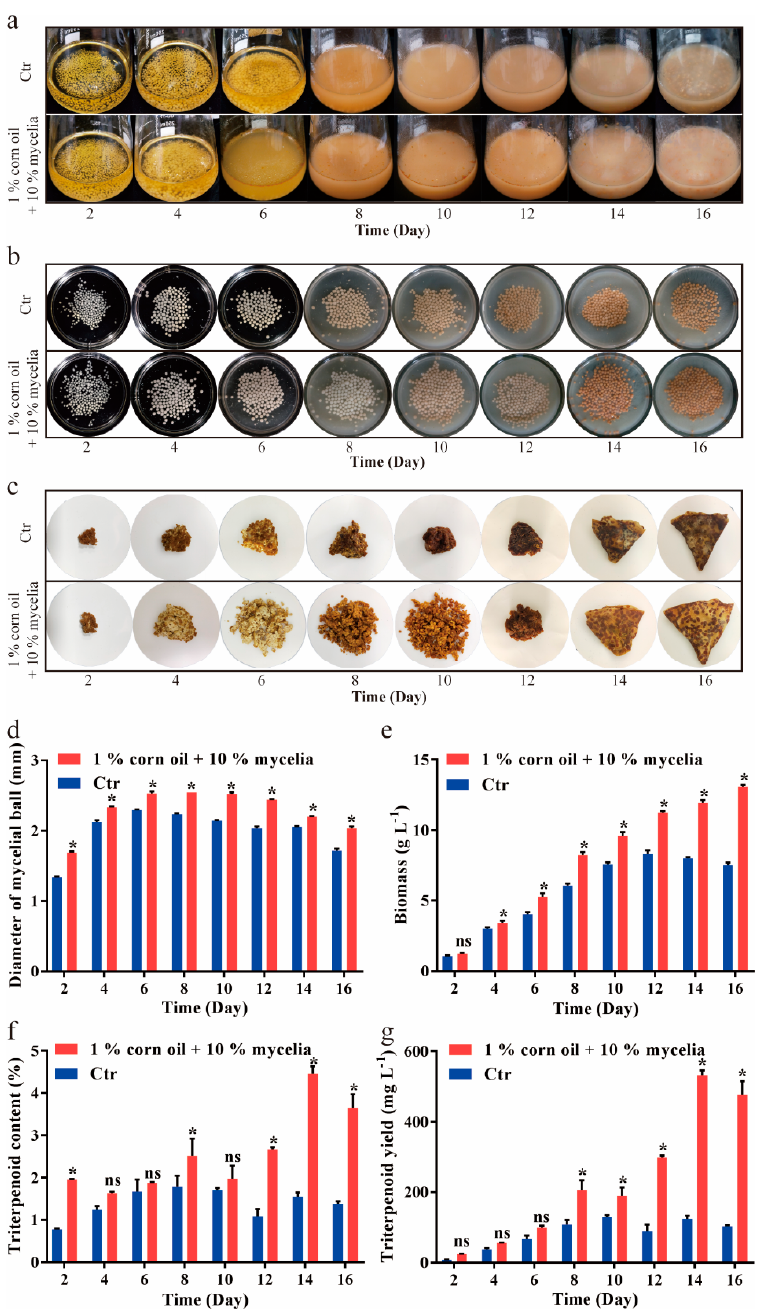
Figure 3. Change of fermentation broth in the optimal fermentations. Fermentation broth ( a ), mycelial ball ( b ) and dried mycelial pellet ( c ) , was presented, respectively. During the optimal fermentations for 16 days, diameter of mycelial ball ( d ), biomass ( e ), triterpenoid content ( f ) and triterpenoids yield ( g ), was quantitatively determined, respectively. The control was the fermentation without oil. All data are from triplicates (means ± SD). Asterisks denote ( * p < 0.05) statistically significant differences between the treatment groups and the control, respectively; ns indicates no significant dif- ference.